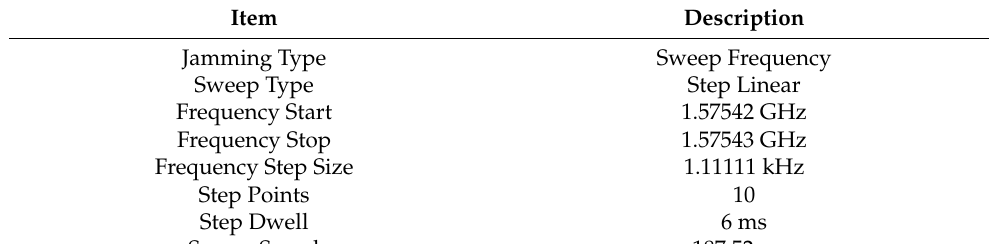
Table 1. Jamming signal parameters.